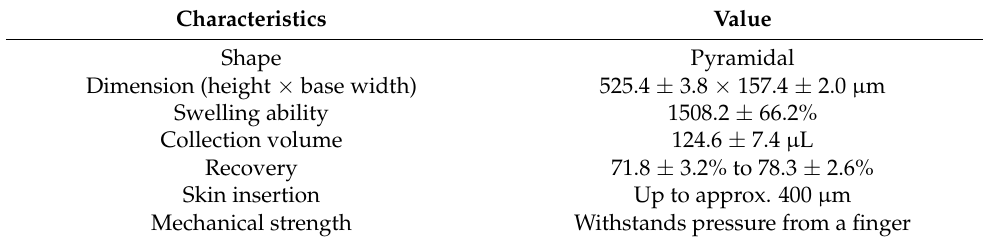
Table 2. Characteristics of the optimal hydrogel-forming MNs.